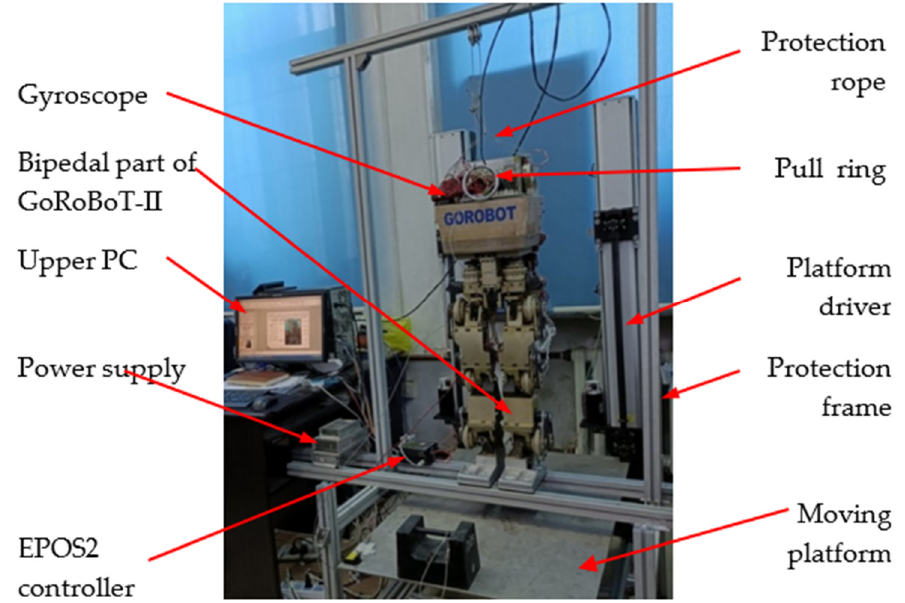
Figure 8. Biped robot stability training experiment system.